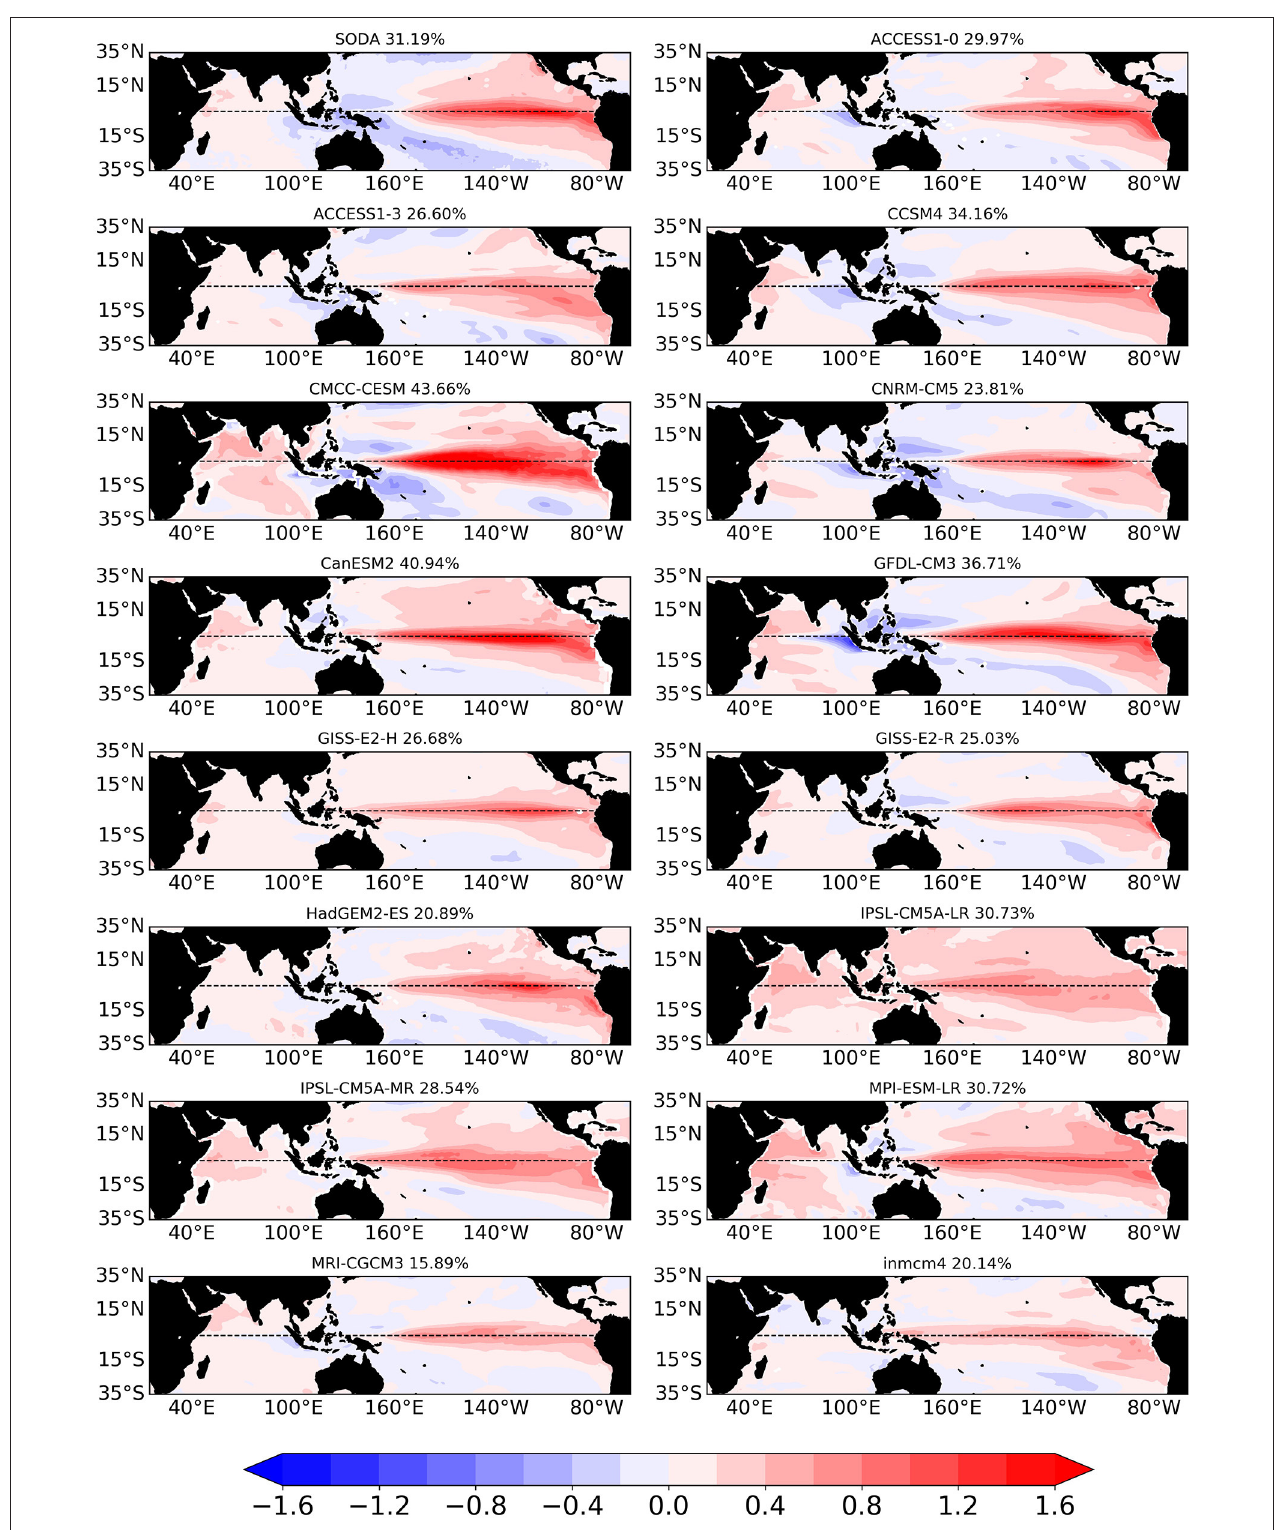
FIGURE 6 | The first EOF patterns of tropical Indo-Pacific sea surface temperature anomalies during the extended boreal fall season (ASON) in 1967–2005 for models and 1980–2018 for SODA reanalysis. Percentages of variance explained by the EOF patterns are included.